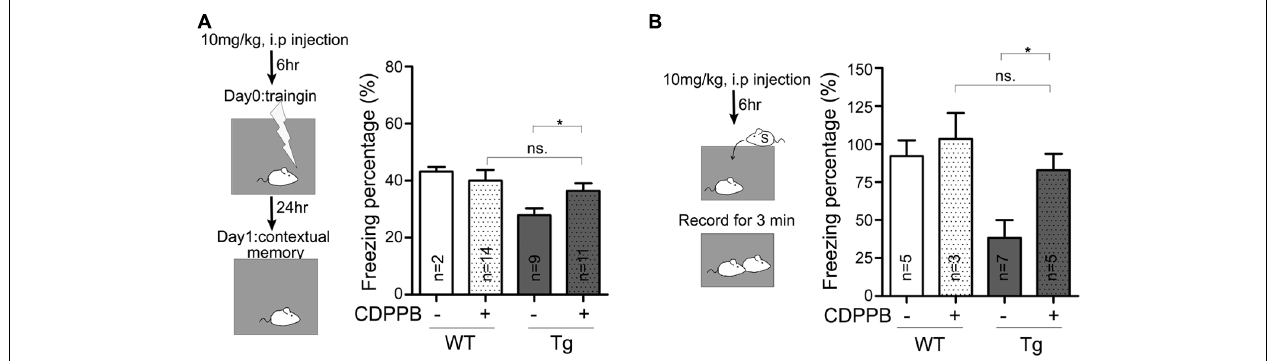
FIGURE 6 | Enhancement of mGluR5 signaling ameliorates the behav- ioral defects in Sarm1 knockdown mice. CDPPB (10 mg/kg of animal body weight) or a vehicle control was intraperitonally injected into mice six hours before the behavioral assay. (A) The results of contextual fear conditioning are